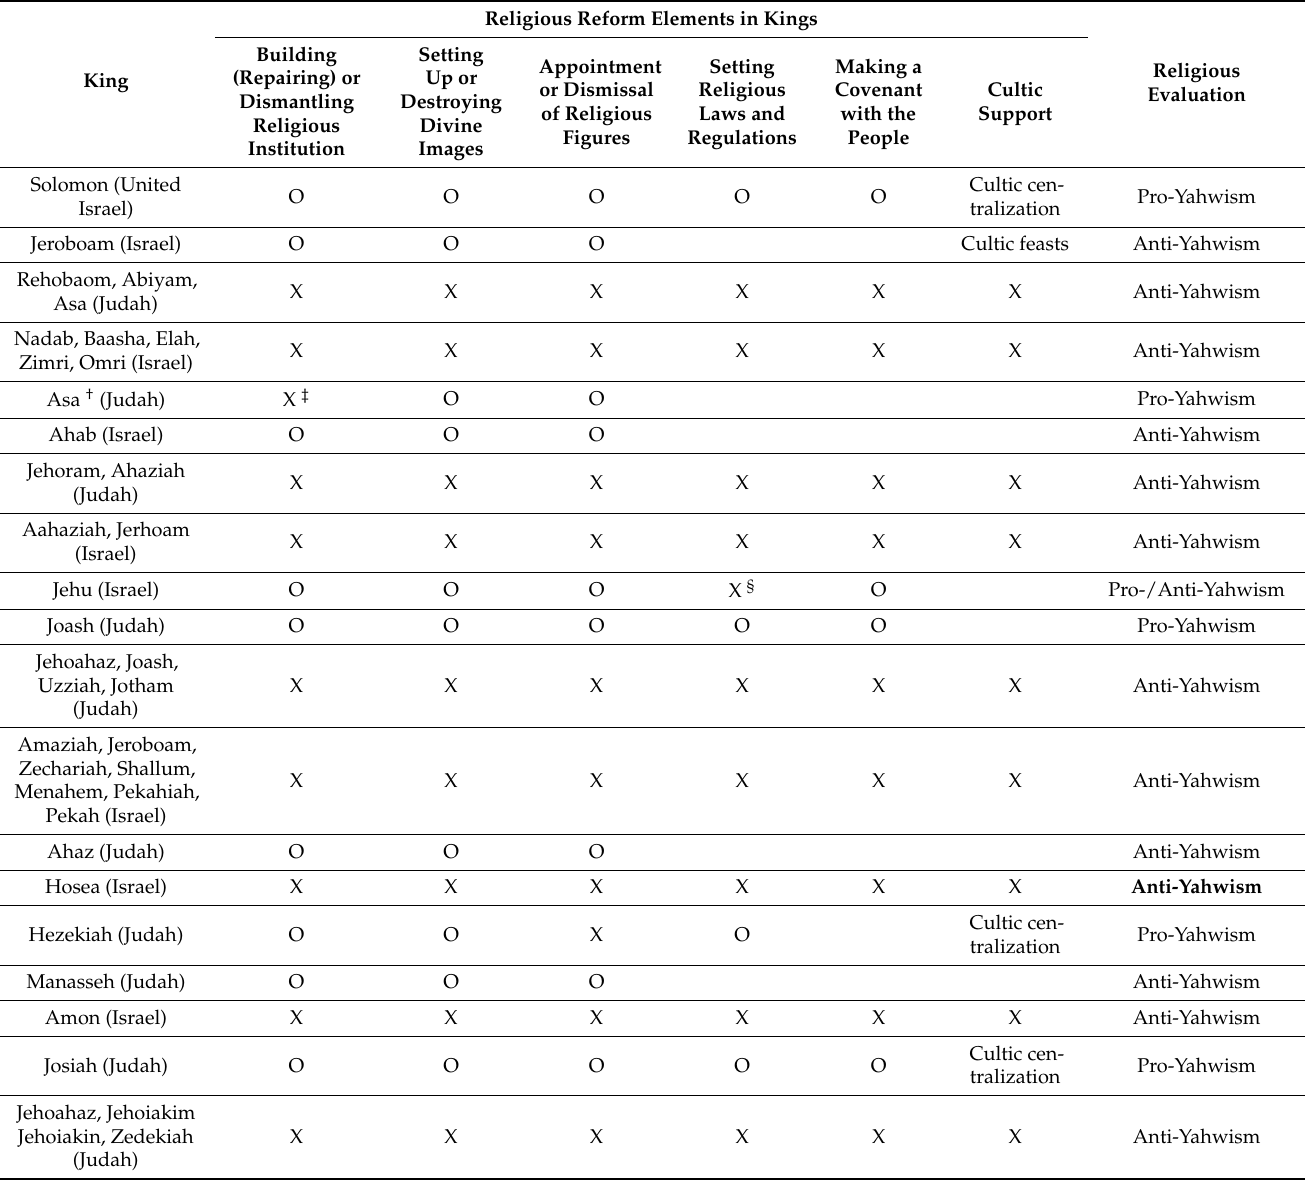
Table 2. Religious reform elements in Kings